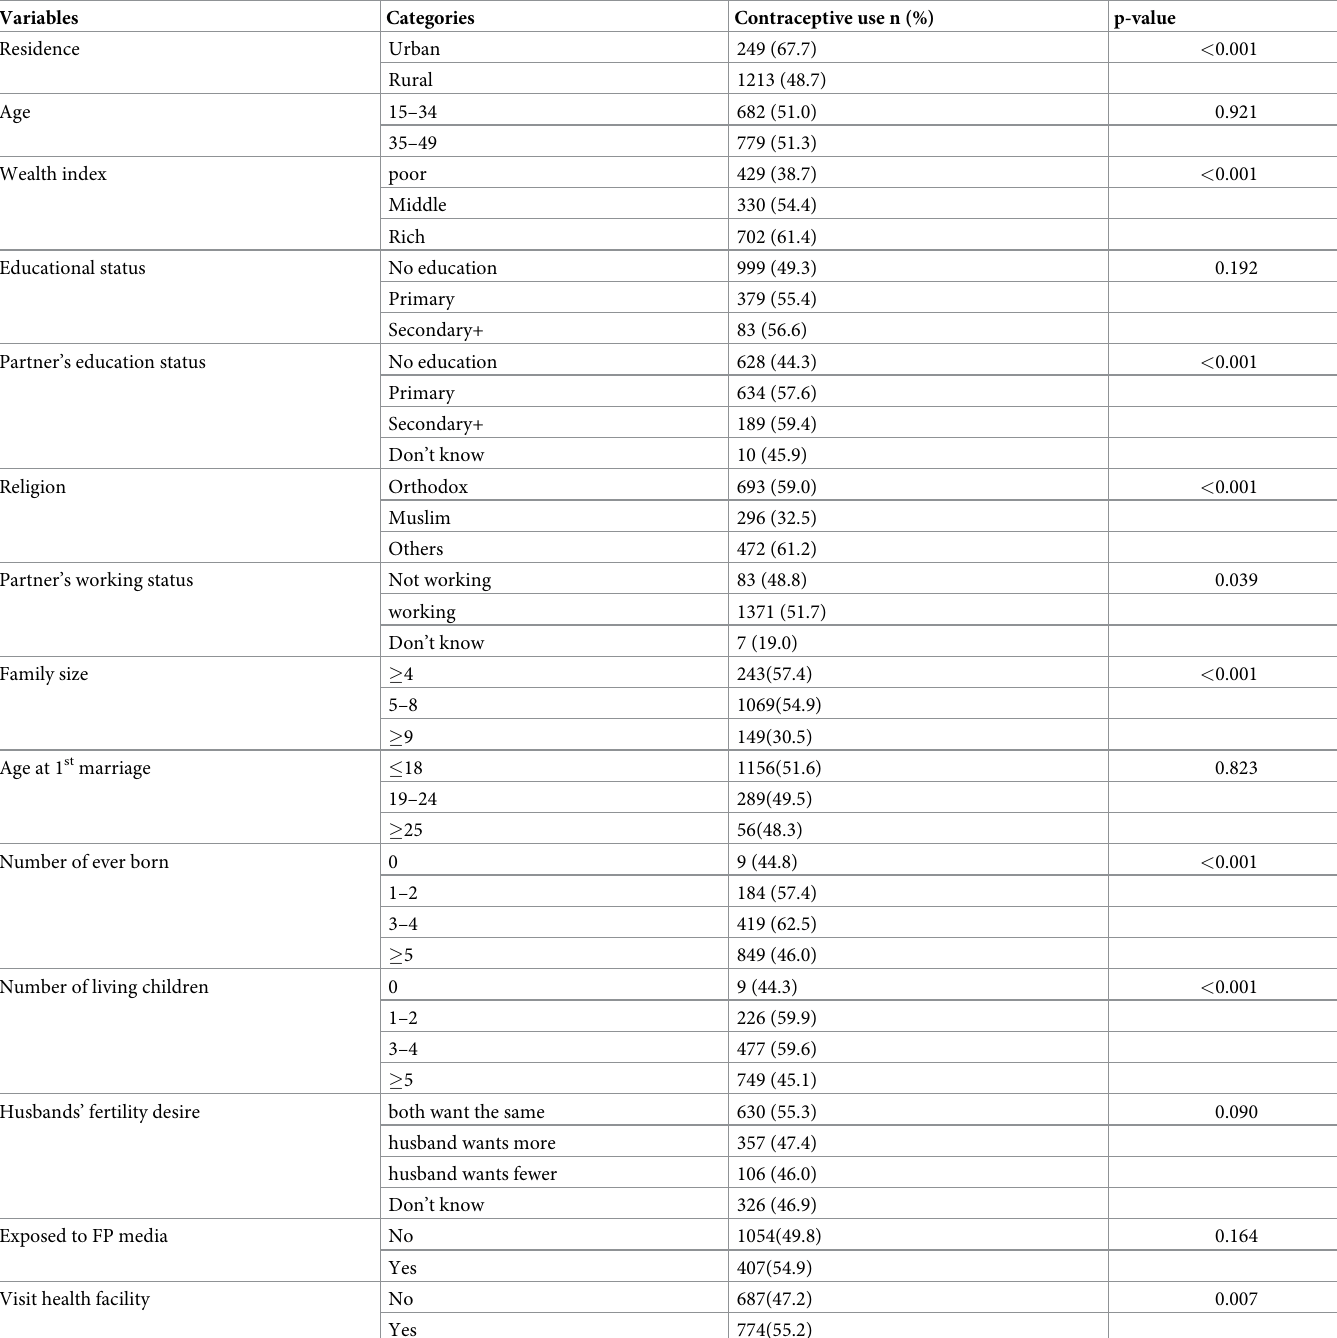
Table 2. Contraceptive use by women’s characteristics among fecund married women who want no more children in Ethiopia, 2016